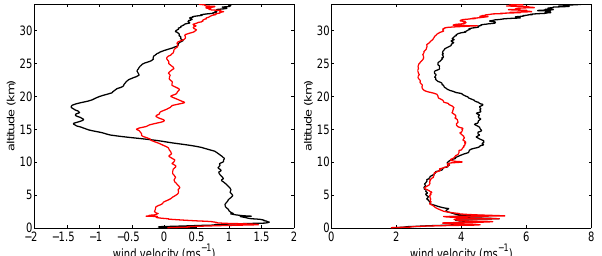
Fig. 14. Observation minus background statistics from high- resolution radiosondes and ECMWF model 12-h forecast. Bias (left) and standard deviation (right) for the zonal (black) and merid- ional wind component